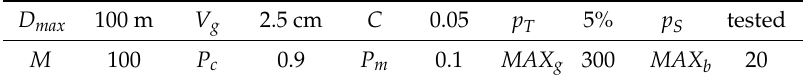
Table 3. The specified algorithm parameters of the evaluation of the GA